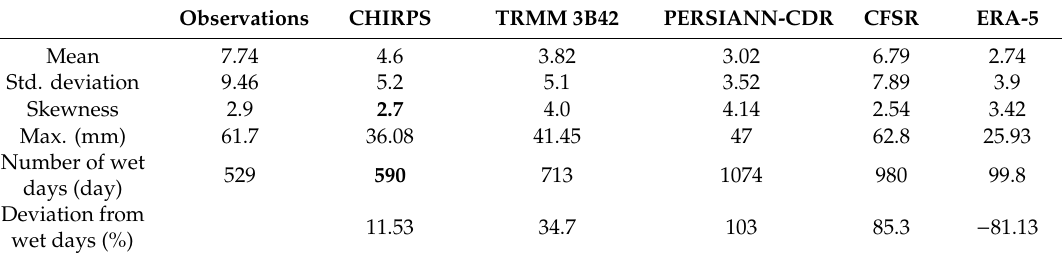
Table 4. Summary of daily average results of the precipitation products in the study area.